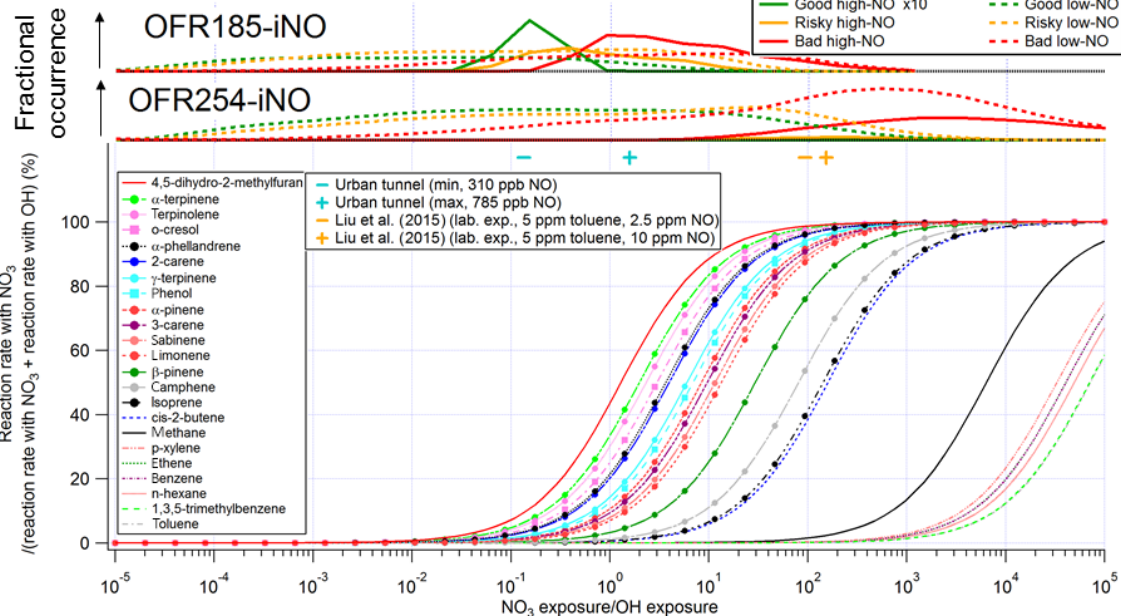
Figure 6. Fractional importance of the reaction rate of several species of interest with NO 3 vs. that with OH as a function of the ratio of exposure to NO 3 and OH. The curves of biogenics and phenols are highlighted by solid dots and squares, respectively. The turquoise and orange markers show the ranges of modeled exposure ratios between NO 3 and OH of a source study in an urban tunnel (Tkacik et al., 2014) and a laboratory study (Liu et al., 2015), respectively, using an OFR. In the upper part of the figure, the modeled frequency distributions of ratios of NO 3 exposure to OH exposure under good/risky/bad high-/low-NO conditions for OFR185-iNO and OFR254-iNO are also shown. See Table 3 for the definitions of the three types of conditions. All curves, markers, and histograms in this figure share the same